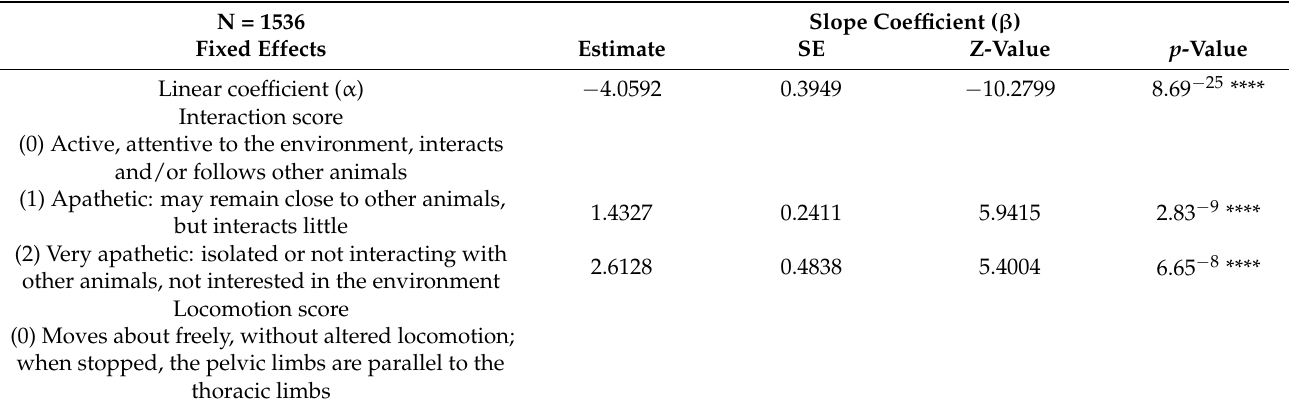
Table 1. Findings based on a multilevel binomial logistic regression algorithm using the expert opin- ion (no-event = no indication of analgesia; event = indication of analgesia) as the predictor